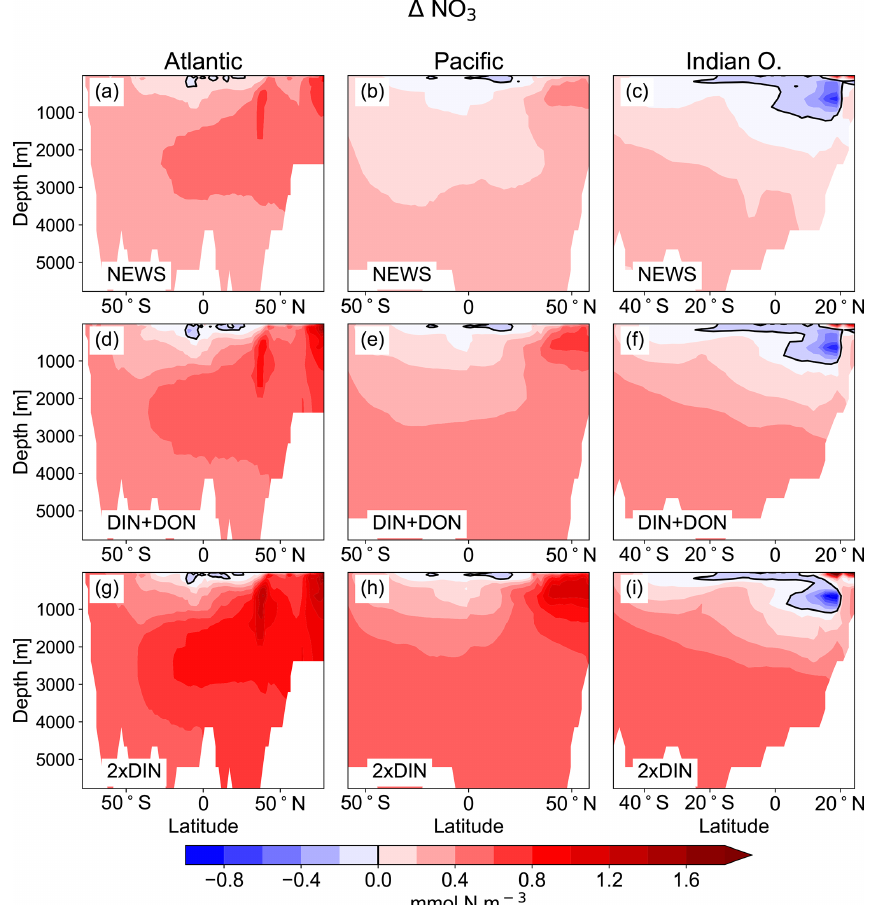
Figure 5. Difference in zonal mean ocean concentrations of NO 3 between the UVic simulations with riverine DIN export and the control simulation. (a, b, c) Difference between NEWS and CTR; (d, e, f) difference between DIN + DON and CTR; (g, h, i) difference between 2 × DIN and CTR. The columns show the zonal mean of the Atlantic Ocean (a, d, g) , the Pacific Ocean (b, e, h) , and the Indian Ocean (c, f, i) basins. The difference in zonal averaged NO 3 concentrations is higher than the color bar maximum at the surface in the northern Indian Ocean basin with a maximum for 2 × DIN at 7.2mmolNm − 3 . Note that the three ocean basins have different sizes in terms of latitudes but for layout reasons the panels have the same